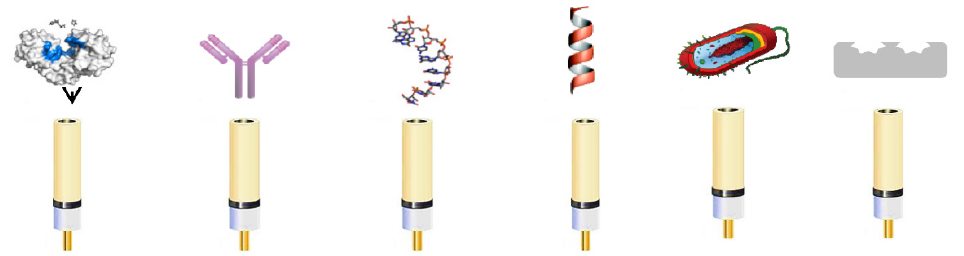
Figure 2. The biological recognition elements used for electrochemical biosensors development (from left to right): enzymes, antibodies, aptamers, peptides, whole cells, and MIP.